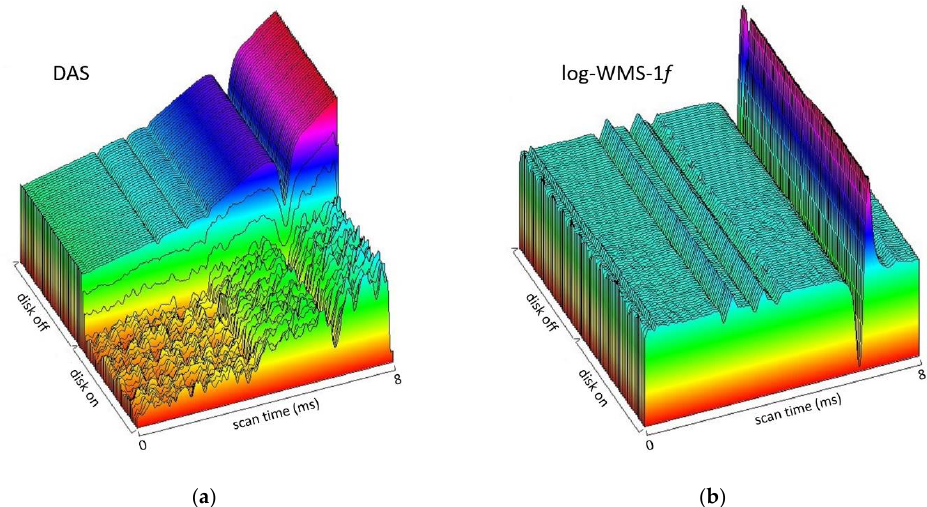
Figure 3. Signals from the photodetector registered in DAS mode ( a ) and log-WMS-1 f mode ( b ) . The 3D spectra registered in DAS mode exhibit well-defined absorption lines in both spectral ranges when there were no extra noises (disk off), but weak lines in the 7466 cm −1 spectral range are indistinguishable in noise with the disk on. On the contrary, absorption lines in both spectral ranges are well detected even with extra noise using the log-WMS-1 f technique. The same results were exhibited in the absorption spectra detected in a single scan. mode are shown in the left panels; signals detected in the log-WMS-1 f mode are shown the sample channel (disk off), while the lower traces were detected with extra noise (disk on). Large differences in the efficiency of the absorption spectra registration in the